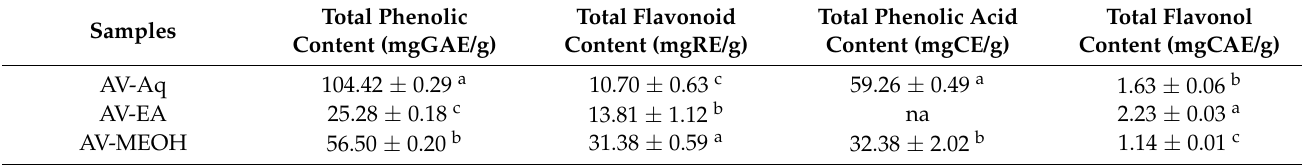
Table 1. Bioactive composition of A. verlotiorum Lamotte extracts.